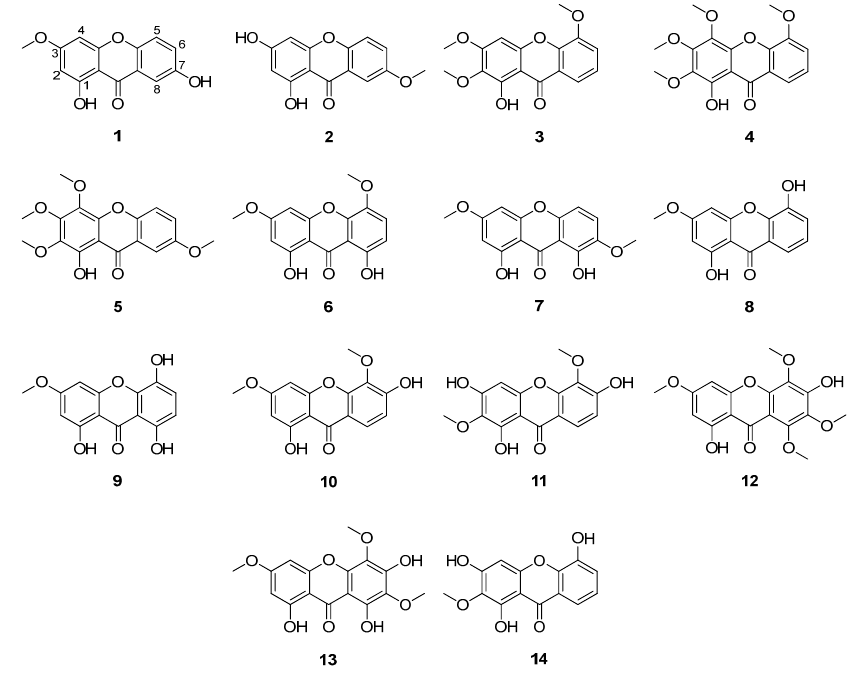
Figure 2. Chemical structures of xanthones 1 – 14 .